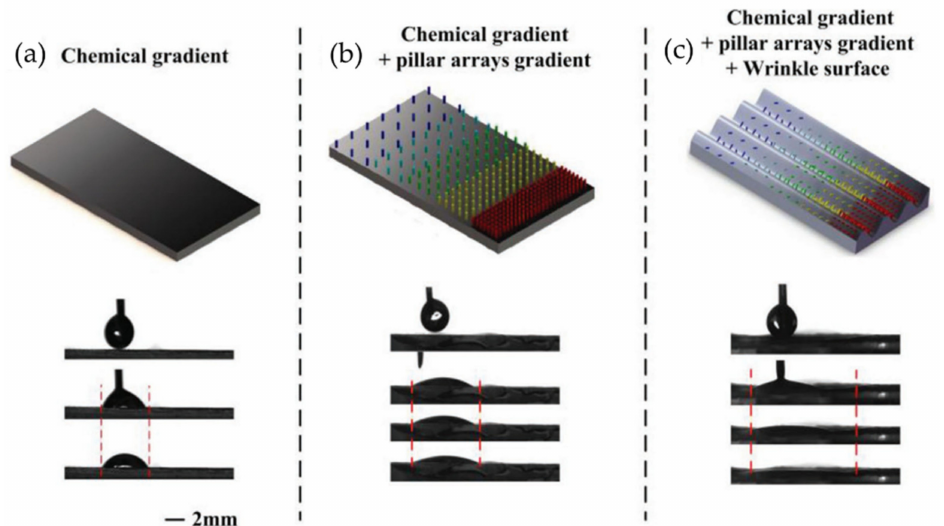
Figure 34. Droplet movement behavior on the surfaces with ( a ) chemical gradient, ( b ) chemical gradient and pillar arrays gradient, and ( c ) double-gradient wrinkled structure. Reproduced with permission from reference [134]. Copyright 2020, John Wiley & Sons,